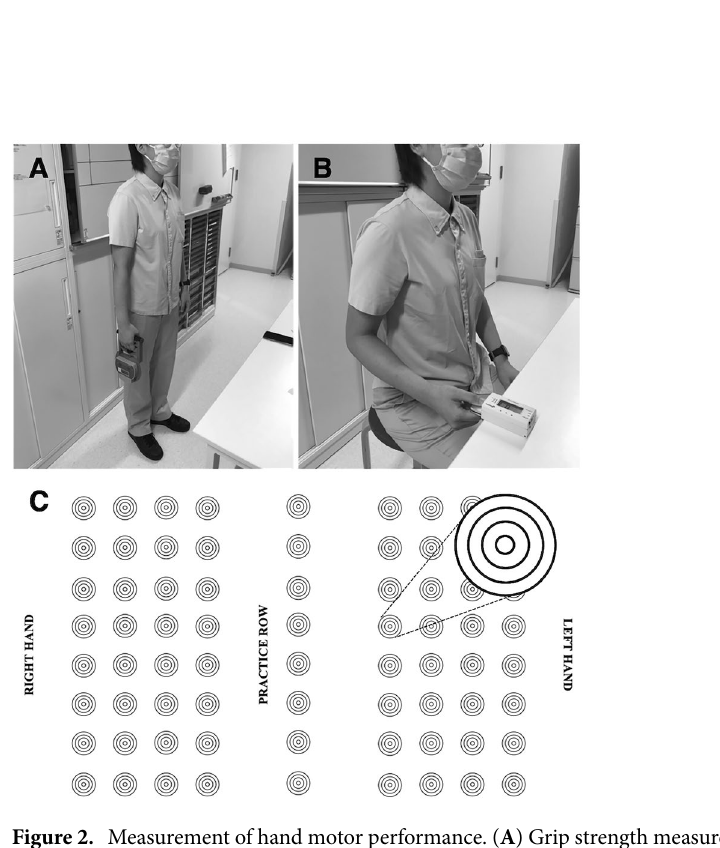
Figure 2. Measurement of hand motor performance. ( A ) Grip strength measurement. ( B ) Lateral pinch strength measurement. ( C ) Paper format of the Target